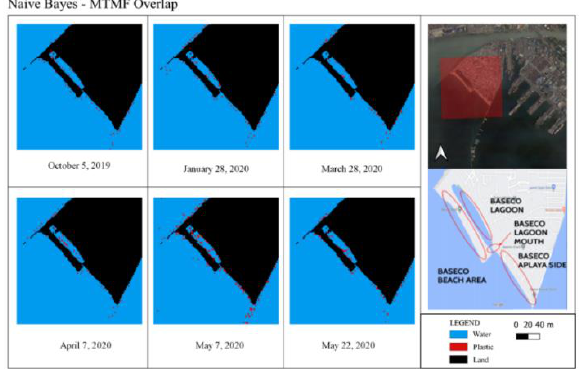
Figure 9 . Comparison of the overlap with the reported location of